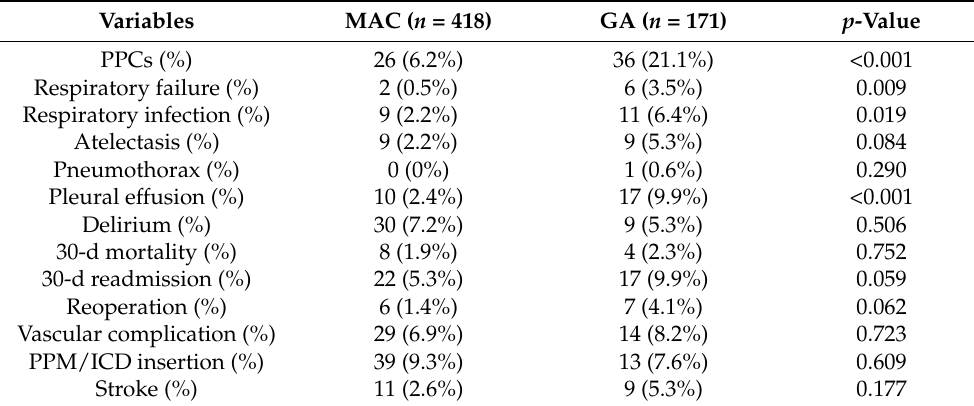
Table 2. Primary and secondary outcomes. Values are presented as the median (interquartile range) or number (percentage).